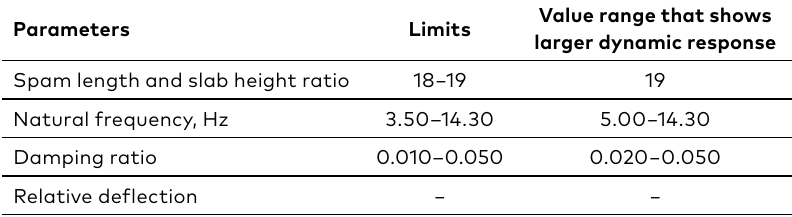
Table 2. Values which indicate increased dynamic reaction